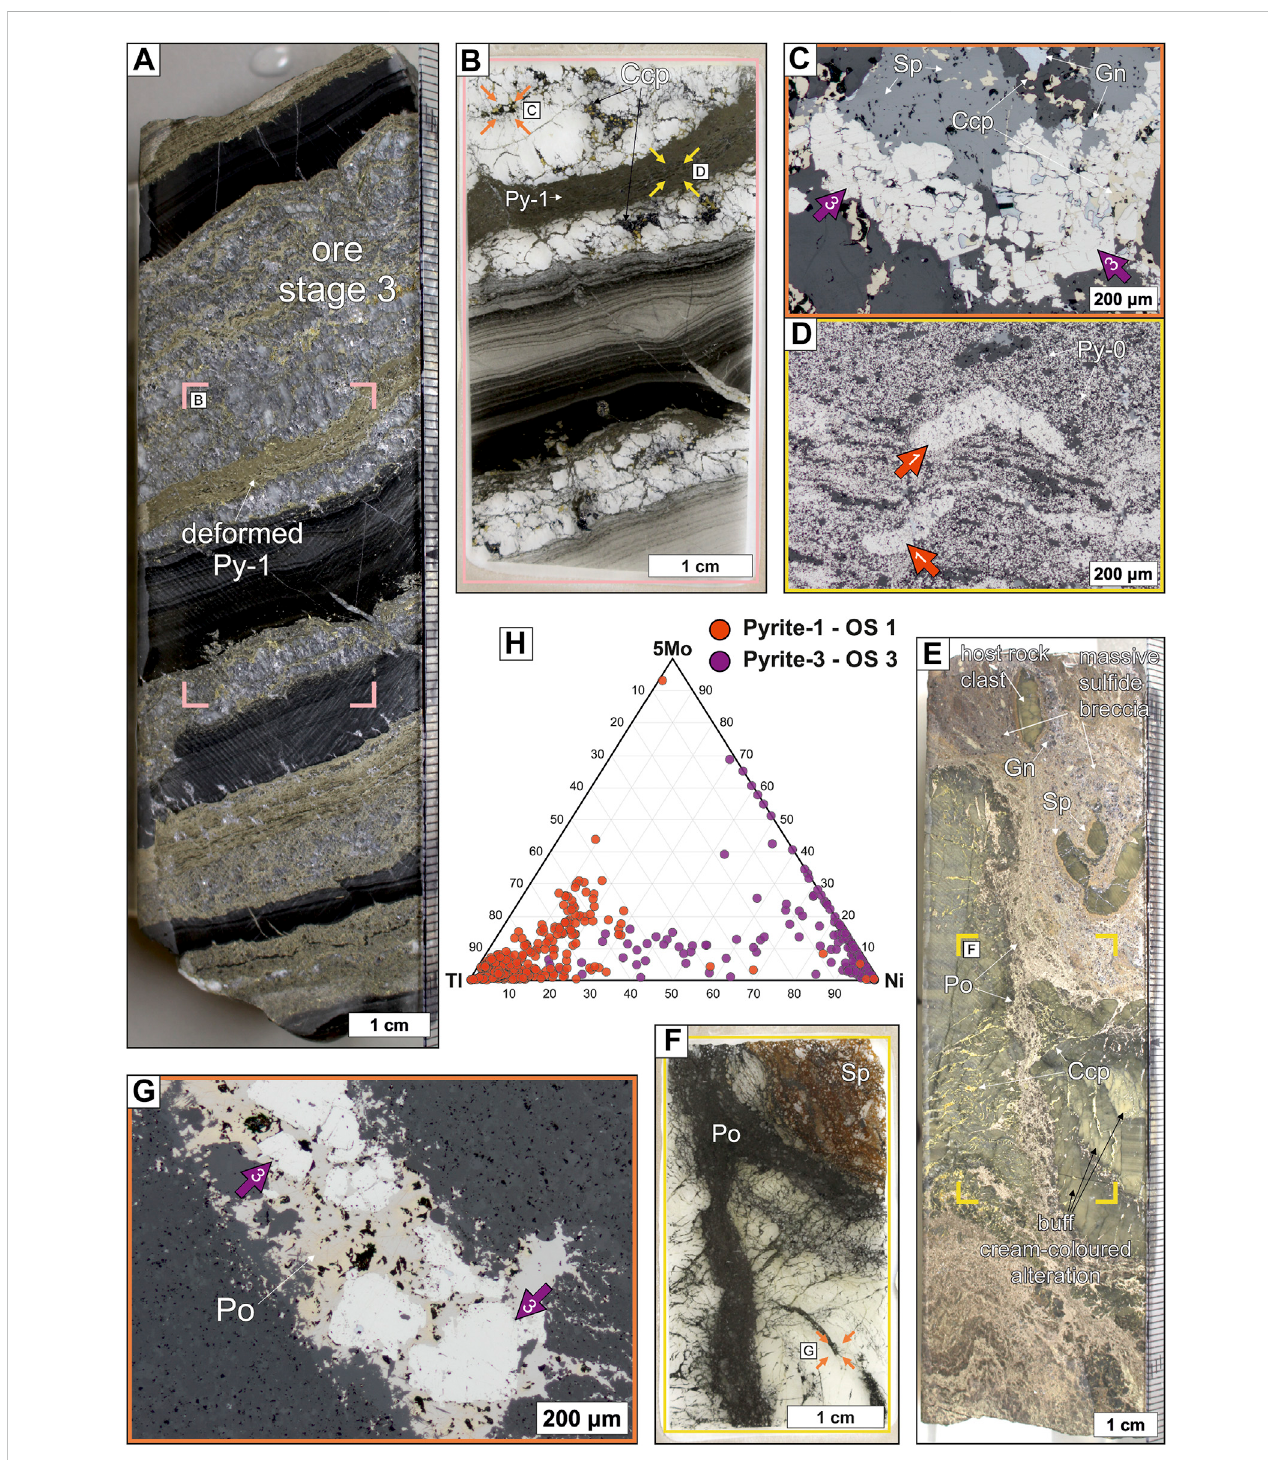
Orestage 1and 3sul fi desamples from theGeorge Fisher deposit containing euhedral to subhedral Py-3, sphalerite (Sp),galena (Gn), pyrrhotite (Po),and chalcopyrite (Ccp). (A) A hand specimen photograph of sample PRK751041 with deformed anhedral Py-1 and with an ore stage 3 vein. The pink rectangle denotesthelocationof (B) . (B) Aphotographofathinsectionofanorestage3veinwithdeformedPy-1.Theorangeandyellowarrowsdenotethelocationsof (C,D) ,respectively. (C) Are fl ectedlightphotomicrographoforestage3coarsegrainedeuhedraltosubhedralPy-3(purplearrows),sphalerite(Sp),galena (Gn), and chalcopyrite (Ccp). (D) A re fl ected light photomicrograph of deformed Py-1 (red arrows). (E) A hand specimen photograph of sample PRK751049 with an ore stage 3 breccia with pyrrhotite (Po), chalcopyrite (Ccp), galena (Gn), and sphalerite (Sp). Note the buff cream-coloured host rock alterationwhichistypicalfor,andrestrictedto,orestage3 atGeorgeFisher.Theyellowrectangledenotesthelocationof (F) . (F) Aphotographofathinsection of an ore stage 3 breccia and veins. The orange arrowsdenote the location of (G) . (G) A re fl ected light photomicrograph of an ore stage 3 vein with pyrrhotite (Po) and coarse grained euhedral to subhedral Py-3 (purple arrows). (H) A ternary diagram of Tl, Ni, and 5*Mo abundances for Py-1 and